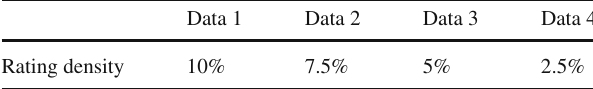
Table 4 Rating densities for different divided subsets